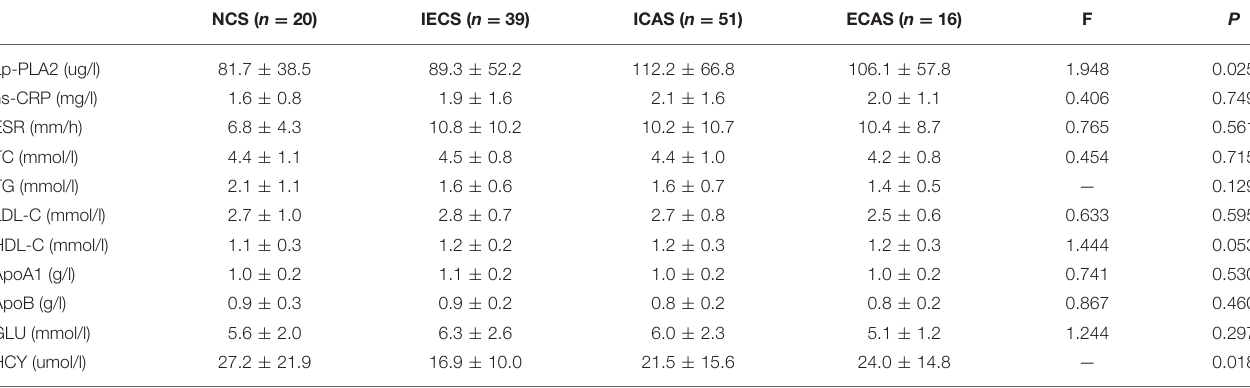
TABLE 3 | Laboratory parameters in patients from different stenosis